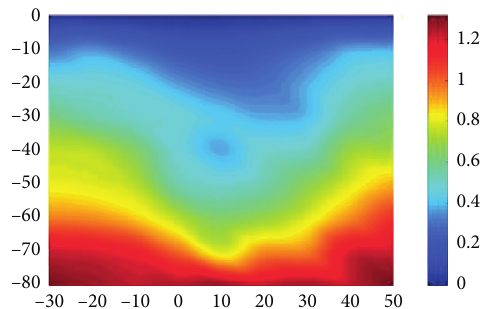
Figure 5: Contour plot of pore water pressure distribution (unit: MPa).